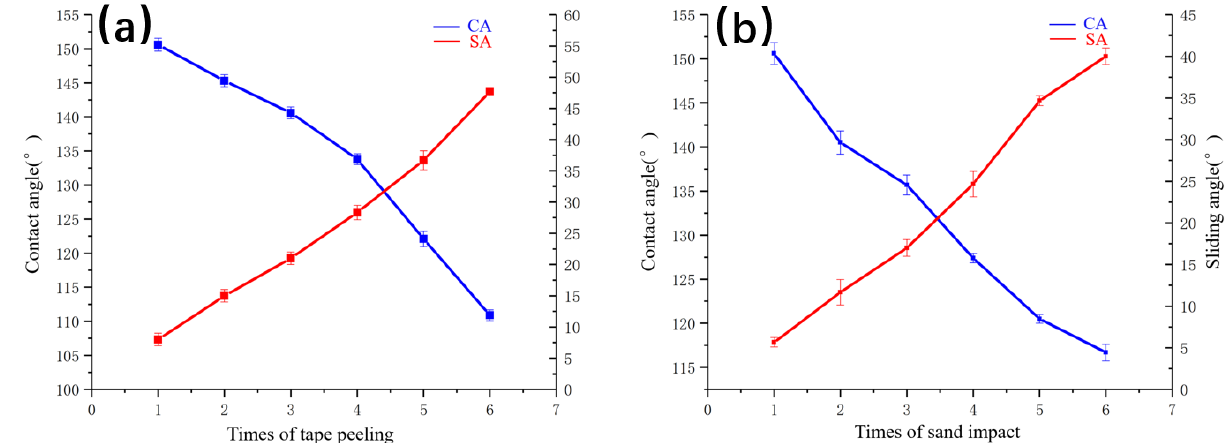
Figure 20. ( a ) CA and SA after tape peeling and ( b ) CA and SA after sand impact.